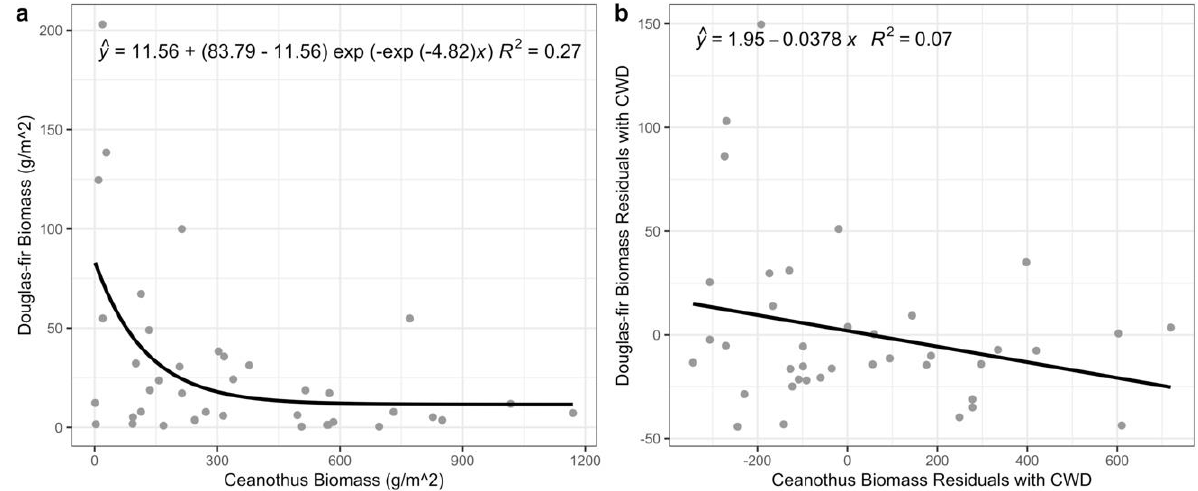
Figure 7. Asymptotic decay regression for Douglas-fir biomass against Ceanothus biomass ( a ). Linear regression between Douglas-fir biomass and Ceanothus biomass residuals with climatic water deficit ( b